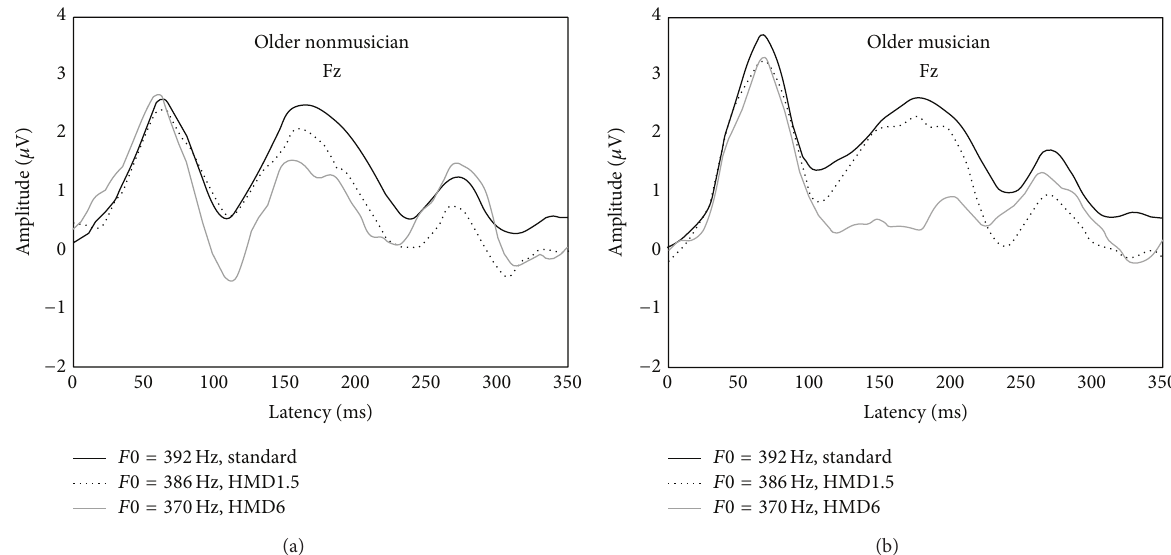
Figure 2: Grand average group CAEP waveforms at Fz for older nonmusicians (a) and older musicians (b). A solid black line represents the CAEP to the standard stimulus while the dotted and gray lines represent CAEPs to deviants presented in the oddball paradigm (i.e., HMD1.5 and HMD6).